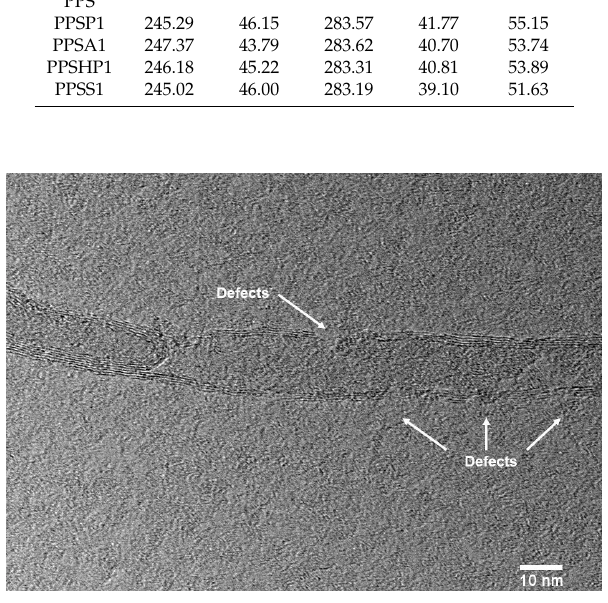
Figure 6. Field-Emission Transmission Electron Microscopy of hydrogen peroxide-treated MWCNTs.